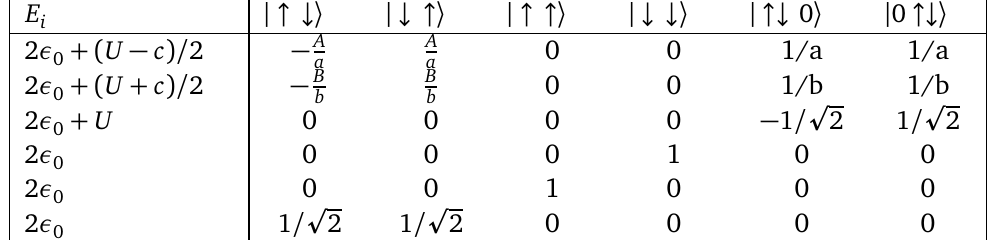
Table 2: Eigenvalues and coefficients of the symmetric Hubbard dimer for N =